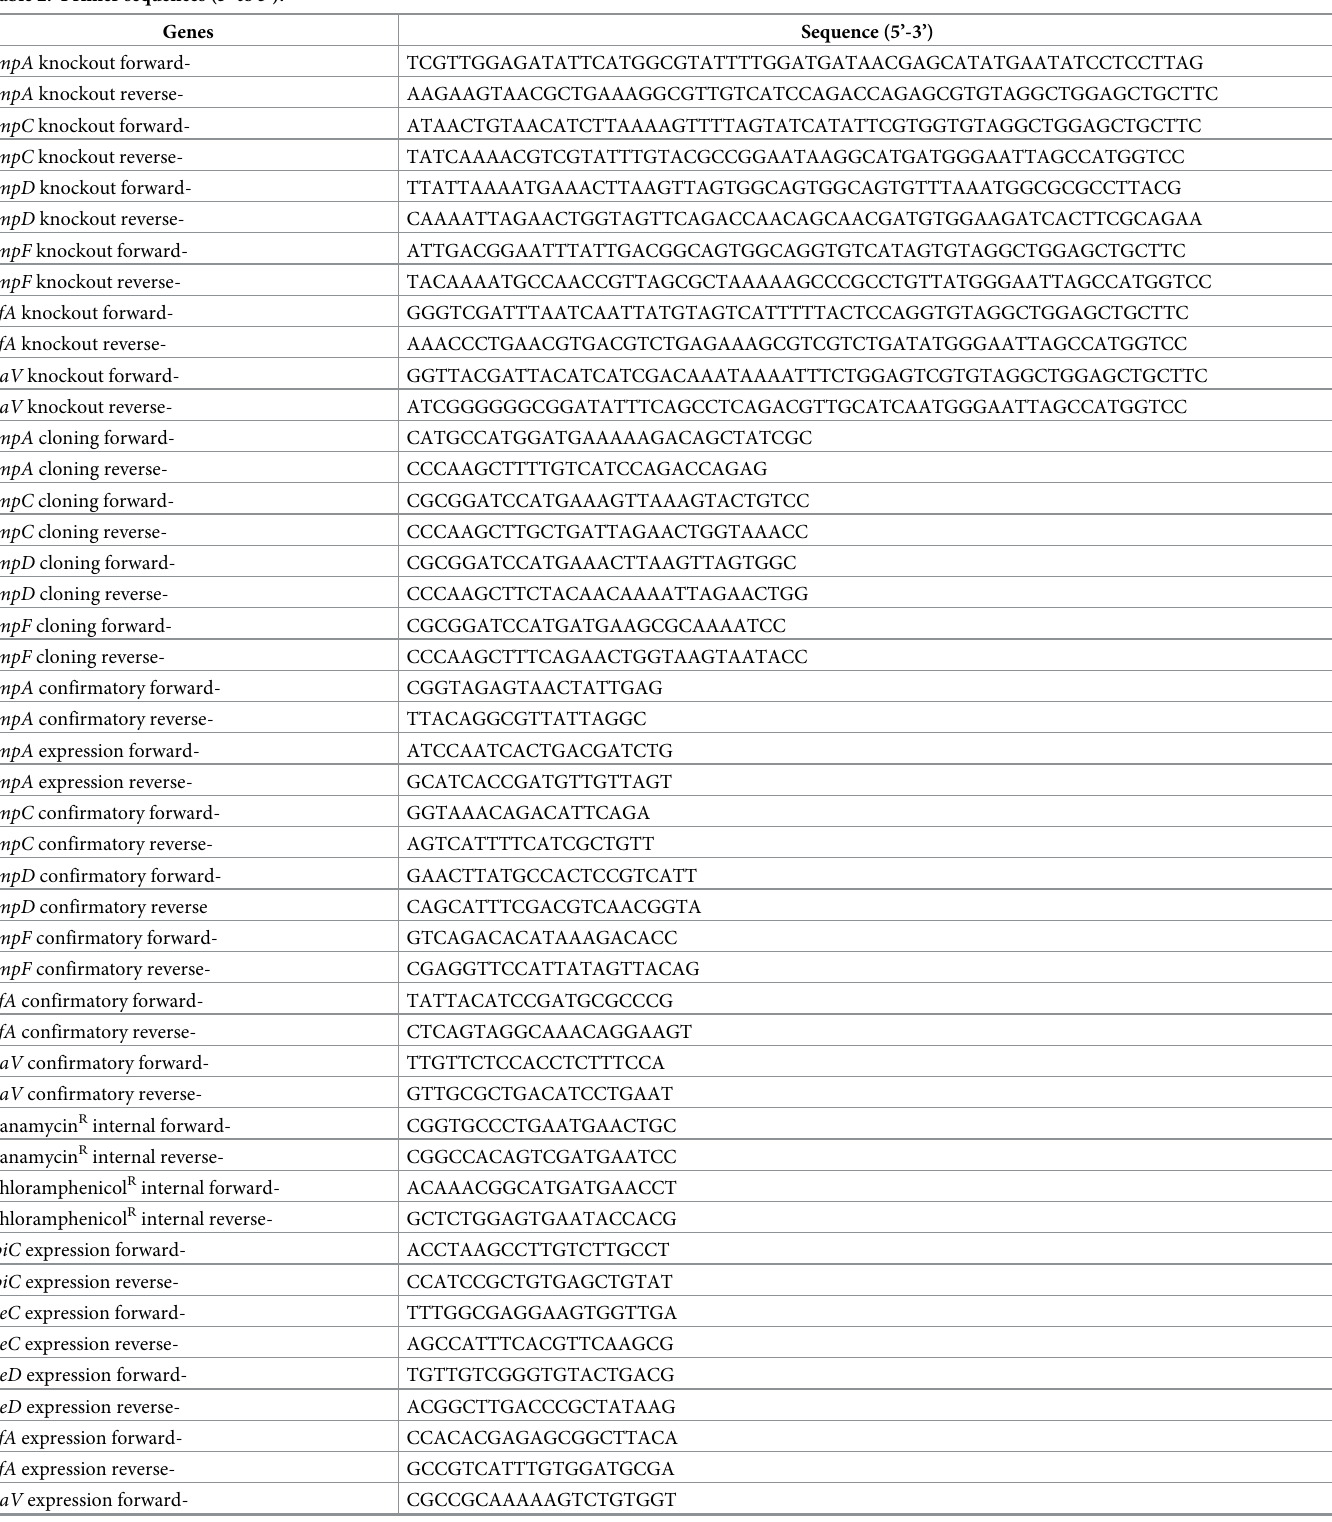
Table 2. Primer sequences (5’ to